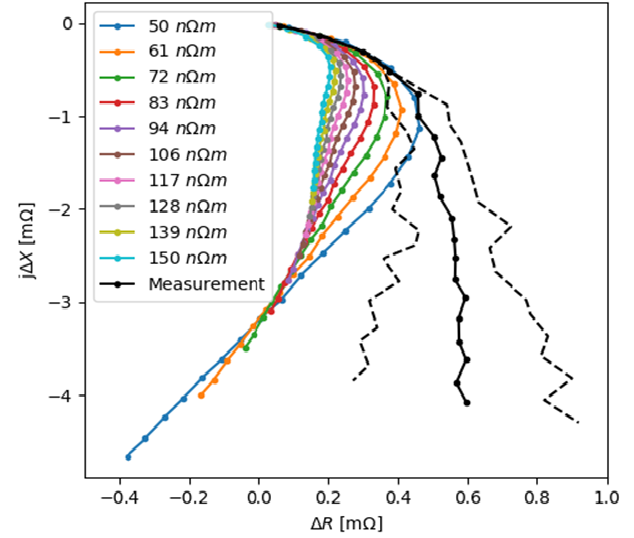
Figure 17. Coil response for HIPIMS Mo coating on MoGr. The measurements are shown with black lines together with the standard deviation (dashed lines) and the simulated response for coating resistivity between 50 n Ω m and 300 n Ω m. The coating has a thickness of 6 µ m, the bulk of 1 mm. The lift-off is 0.7